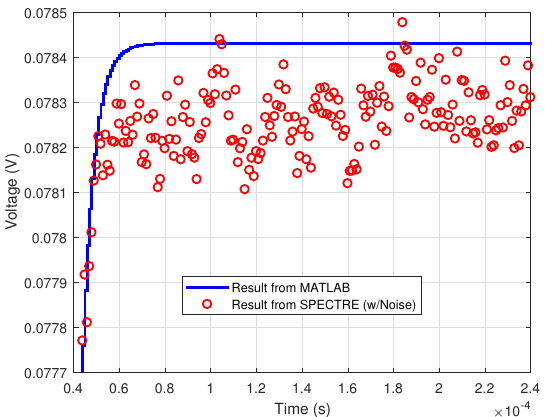
Figure 16. Ideal output from MATLAB implementation (blue curve) compared with output from SPECTRE (red points) in presence of thermal